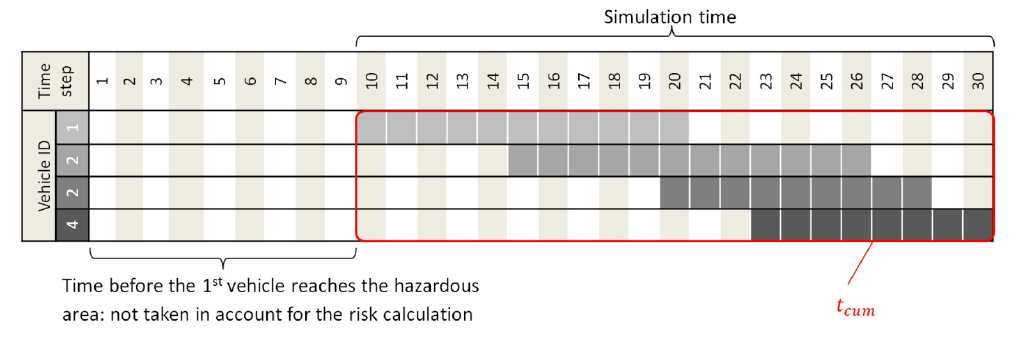
Fig. 3. Cumulated time of vehicles observed in the hazardous area during one simulation. In this example, four vehicles passed through the hazardous area with a total of 40 time steps of cumulated time. Here, one time step is equal to one second. During the first 9s of the simulation, no vehicle has reached the hazardous area. Thus, time required by the first vehicle to reach the hazardous zone is not included in the simulation